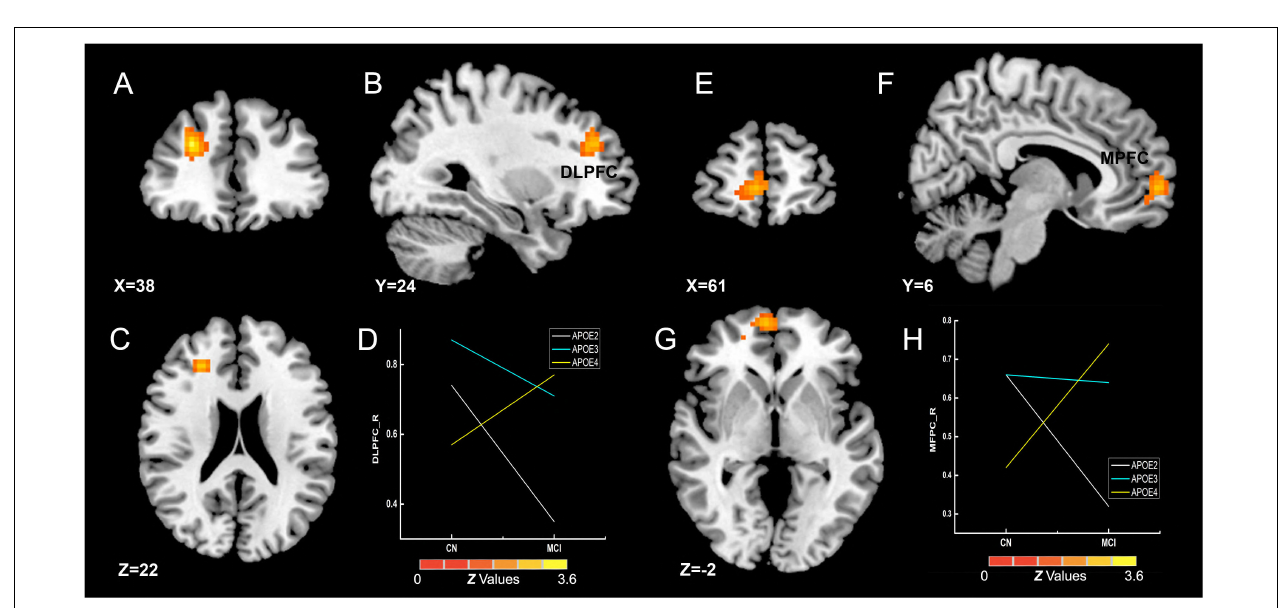
FIGURE 3 | Primary outcome of the APOE genotypes on gFCD ( p < 0.005; α < 0.001; 3dClustSim corrected). (A–C,E–G) Influence of APOE genotype on the brain functions of different brain regions. (D,H) The histograms quantitatively illustrate the gFCD differences among the three APOE genotypes. The asterisks mean significant difference between two APOE genotype groups. Compared to APOE ε 3 ε 3 and ε 4+ genotypes, the APOE ε 2 + genotype show higher gFCD values in the PCC and right thalamus (D) , and lower gFCD values in the bilateral precentral gyrus (H) . No significant difference was found in brain functions between the two APOE ε 3 ε 3 and ε 4+ genotype groups. gFCD, global functional connectivity density; PCC, posterior cingulate cortex; THA, thalamus; Pre, precentral gyrus.